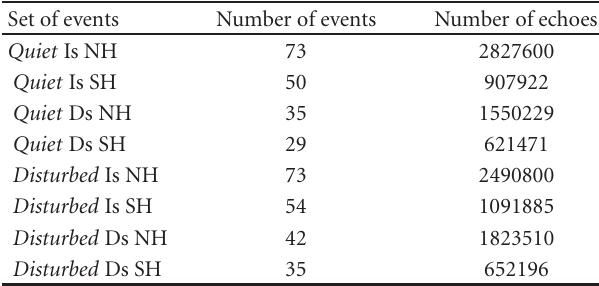
Table 1: An overview of the echoes statisticsfor the di ff erent subsets of the events under study. Is and Ds stand for Increases and Decreases of solar wind dynamic pressure, NH and SH stand for Northern and Southern Hemisphere. Set of